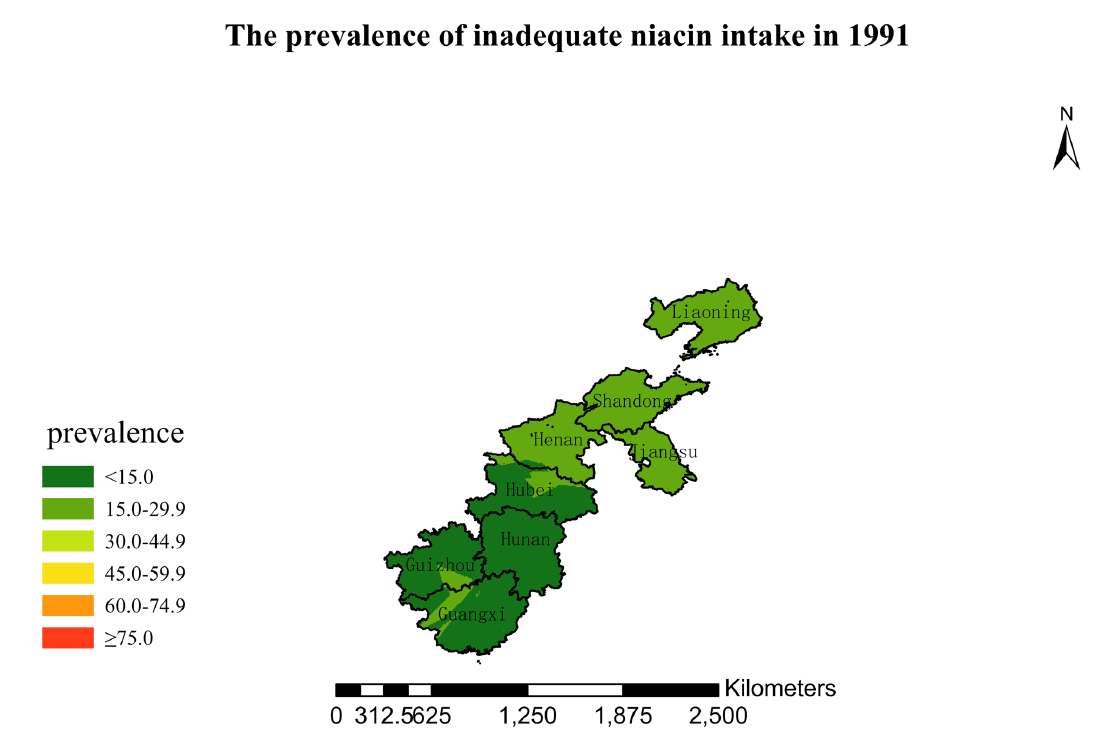
Figure 1. The prevalence of inadequate niacin intake by county in 1991 among Chinese Residents ≥ 5 Years of Age.